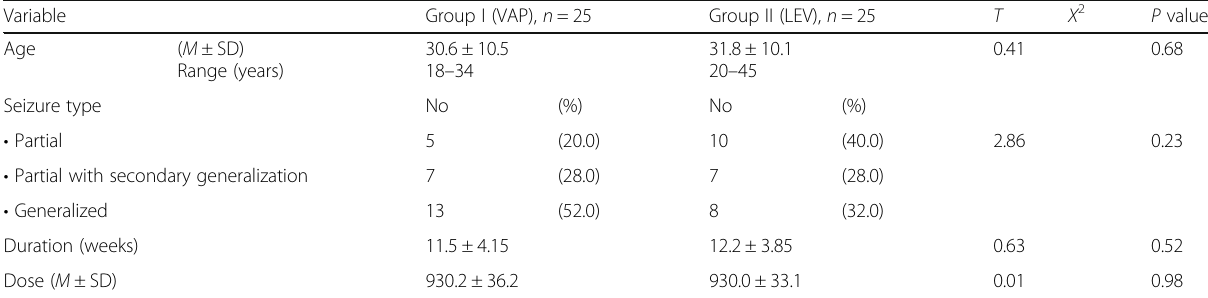
Table 1 Baseline characteristics of the studied groups